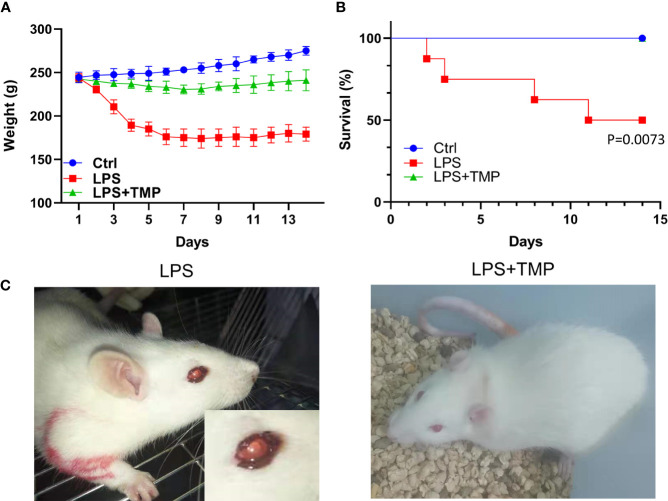
Weight change and survival rate of rats with LPS-induced sepsis. (A) The trends of weight changes of rats in the control group, LPS group and LPS+TMP group for 14 days; (B) The survival rates of each group for 14 days. (C) Modeling and enlarged eye detail of rats in the LPS and LPS+TMP groups 4 h after injection with LPS.